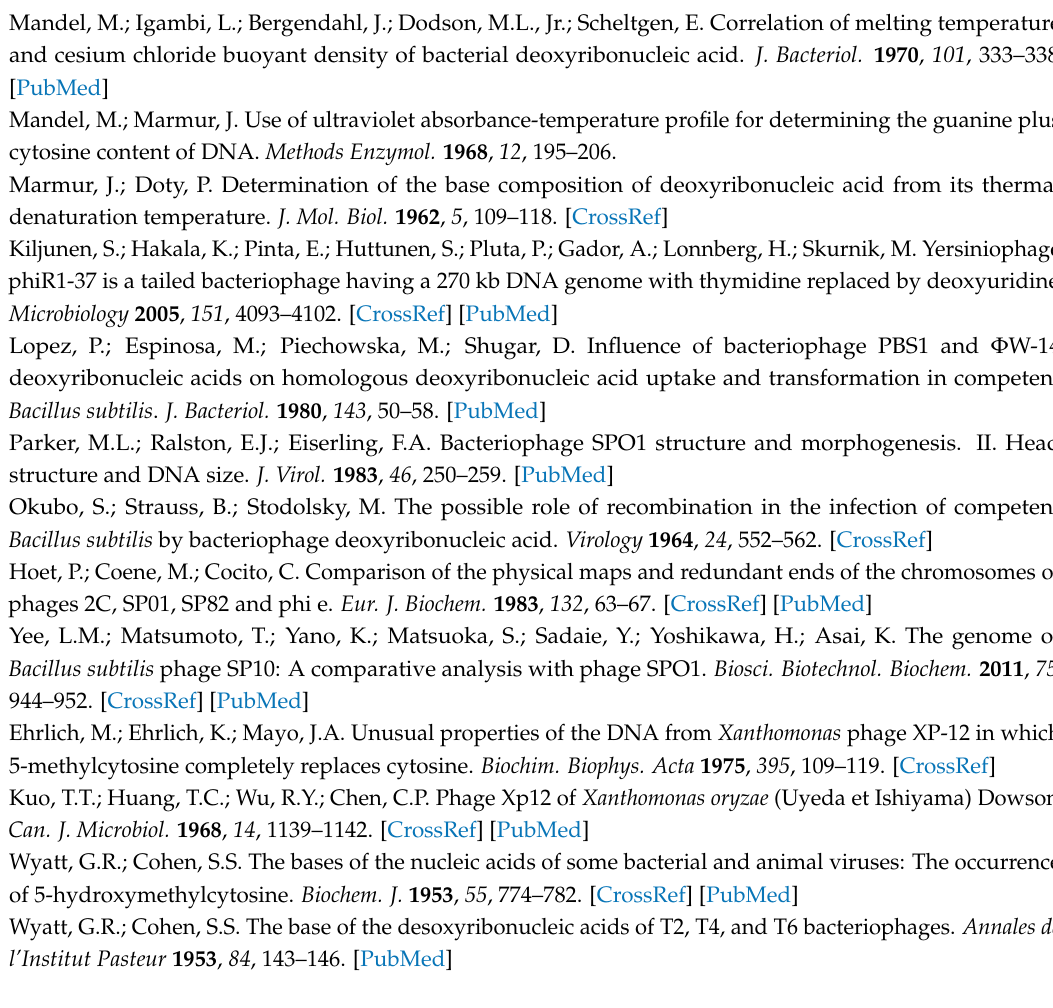
Figure S1: Delftia phage phiW-14 genomic map, Table S1: Delftia phage phiW-14 genome features, Figure S2: Bacillus phage SP-15 genomic map, Table S2: Bacillus phage SP-15 genome